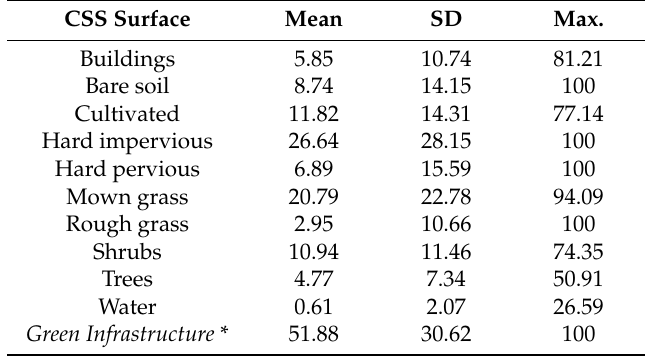
Table 4. Proportional surface coverage (%) of an average Manchester garden from the CSS responses with valid estimation range ( n = 758). All categories reported minimum values of